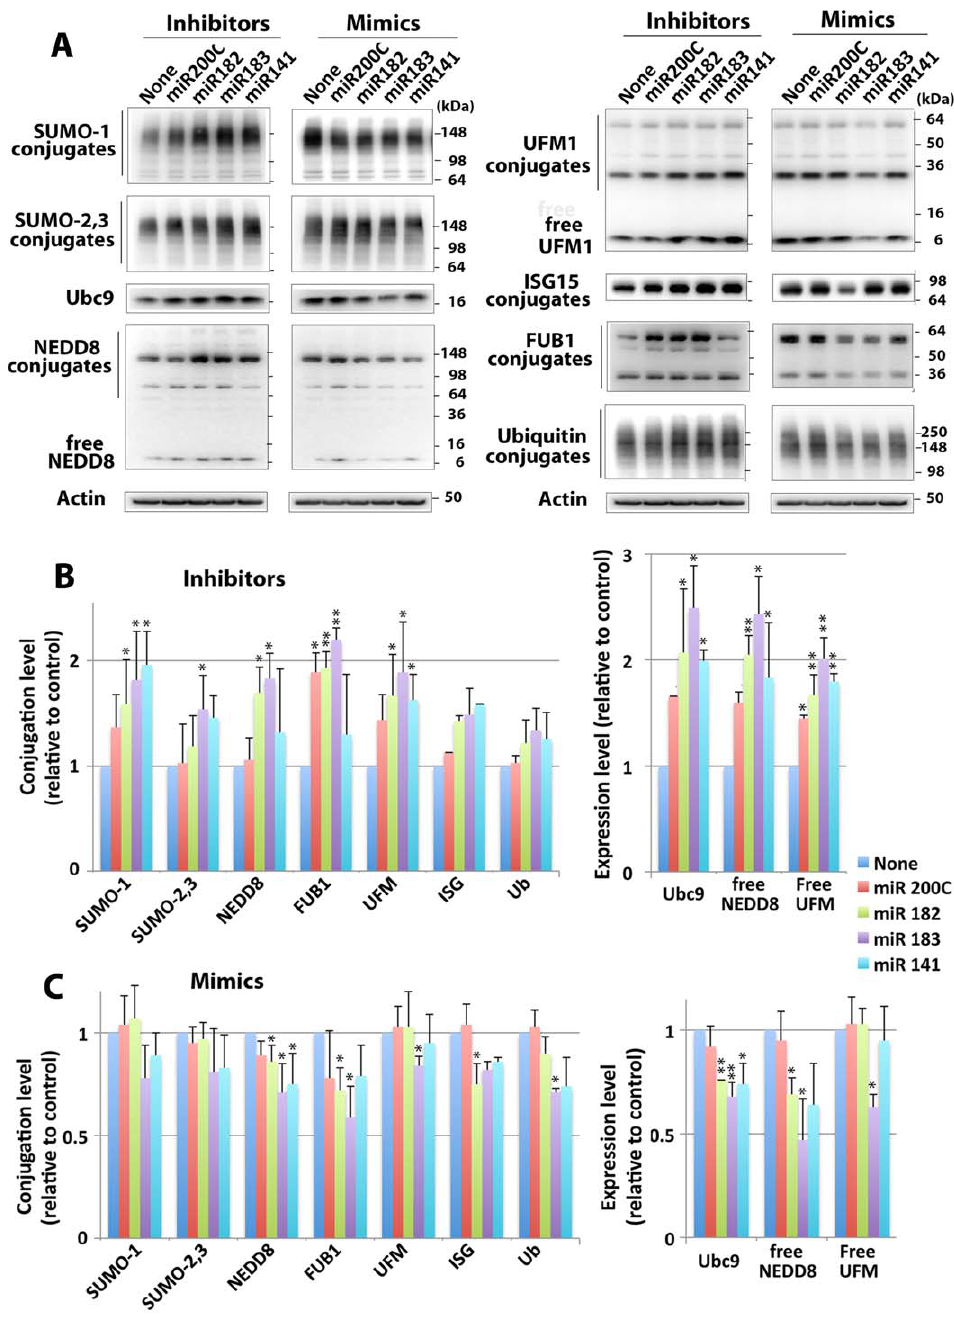
Figure 4. Effect of miRNA inhibitors and mimics for miR-200 family and miR-182 family members on ULM conjugation levels in SHSY5Y cells. (A) Representative Immunoblots of various ULMs in SHSY5Y cells that had been transfected with either miR inhibitors (left column) or mimics (right column) in each panel. (B) Quantitative analyses of the conjugates (left panel) or free form (right panel) of various ULMs in inhibitor- transfected SHSY5Y. (C) Quantitive analyses of the conjugates (left panel) or free form (right panel) of various ULMs in mimic-transfected SHSY5Y cells. Densities of conjugates or free forms were measured, normalized by corresponding b -actin level, and shown as the ratio to endogenous (negative control-transfected) level. Data represent the mean 6 SD of three independent experiments. **p , 0.01, *p , 0.05 compared with endogenous level.